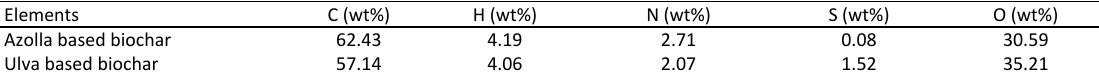
Table 6: Ultimate analysis for the biochars obtained from the pyrolysis of A. filiculoide and U. fasciata